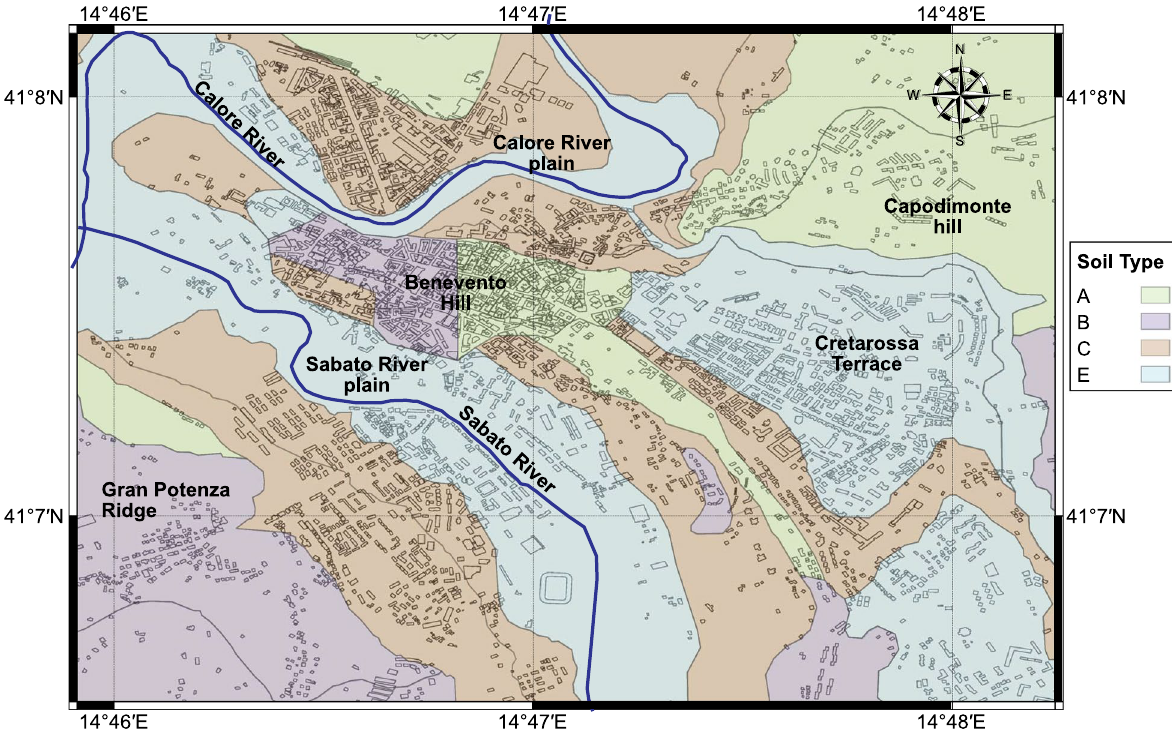
Figure 2. Geological map of Benevento, including ground classification according to Eurocode 8 17 . The average shear wave velocity V s ,30 ; for each ground type ranges as follows: ( A ) (Rock, V s ,30 > 800 m/s-in green); ( B ) (very dense sand and gravel, V s ,30 : 360–800 m/s-in purple); ( C ) (dense sand and gravel, V s ,30 : 180–360 m/s -in brown); ( E ) (surface alluvium layer with thickness between 5 and 20 m, V s ,30 : 180–360 m/s or <180 m/s-in light blue). This figure is created with QGIS version 3.18.2 (https:// www. qgis. org/).